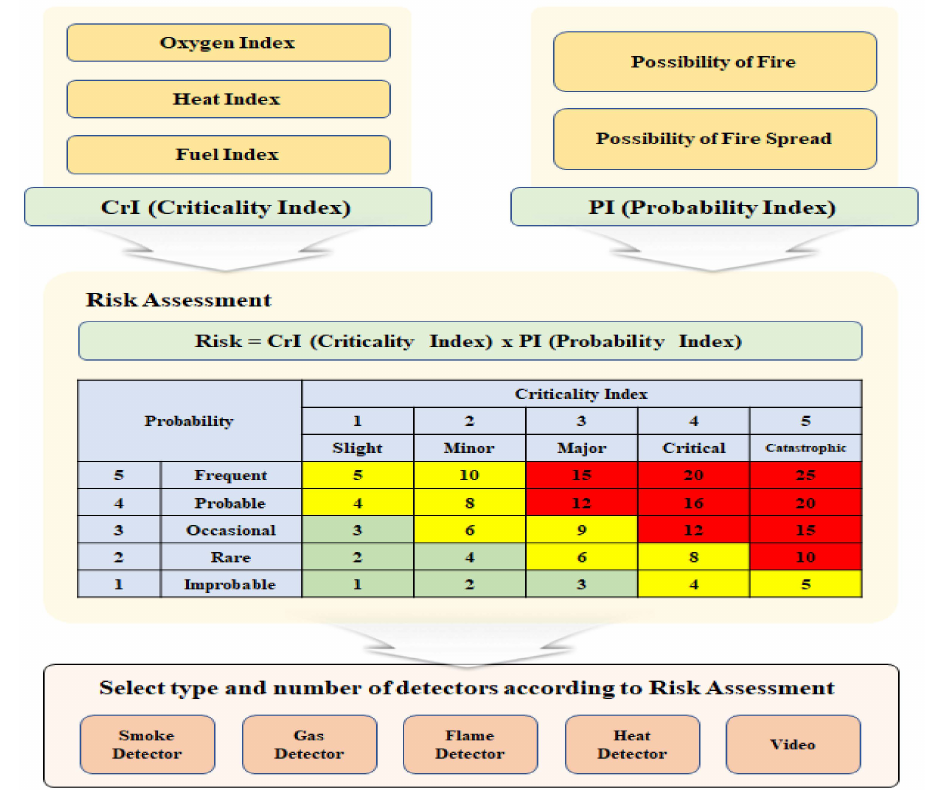
Figure 10. Selecting a detection system based on risk